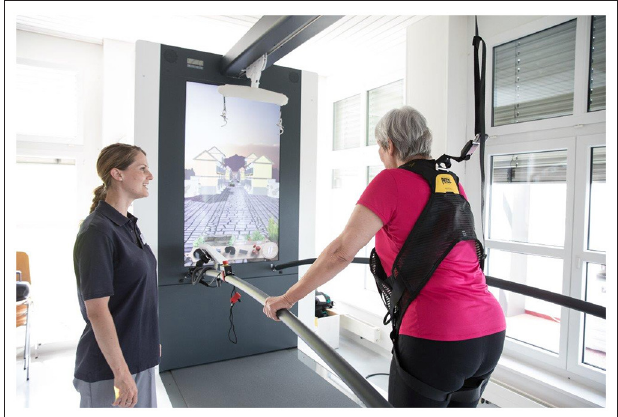
FIGURE 3 | Treadmill training by using the C-Mill (MOTEK, the Netherlands) which may include training on a display and on the floor (augmented reality).